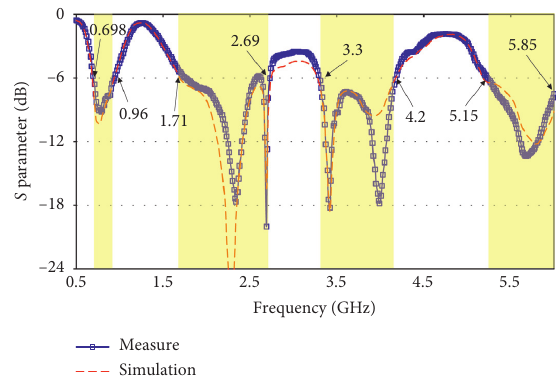
Figure 3: S 11 values derived from simulation and